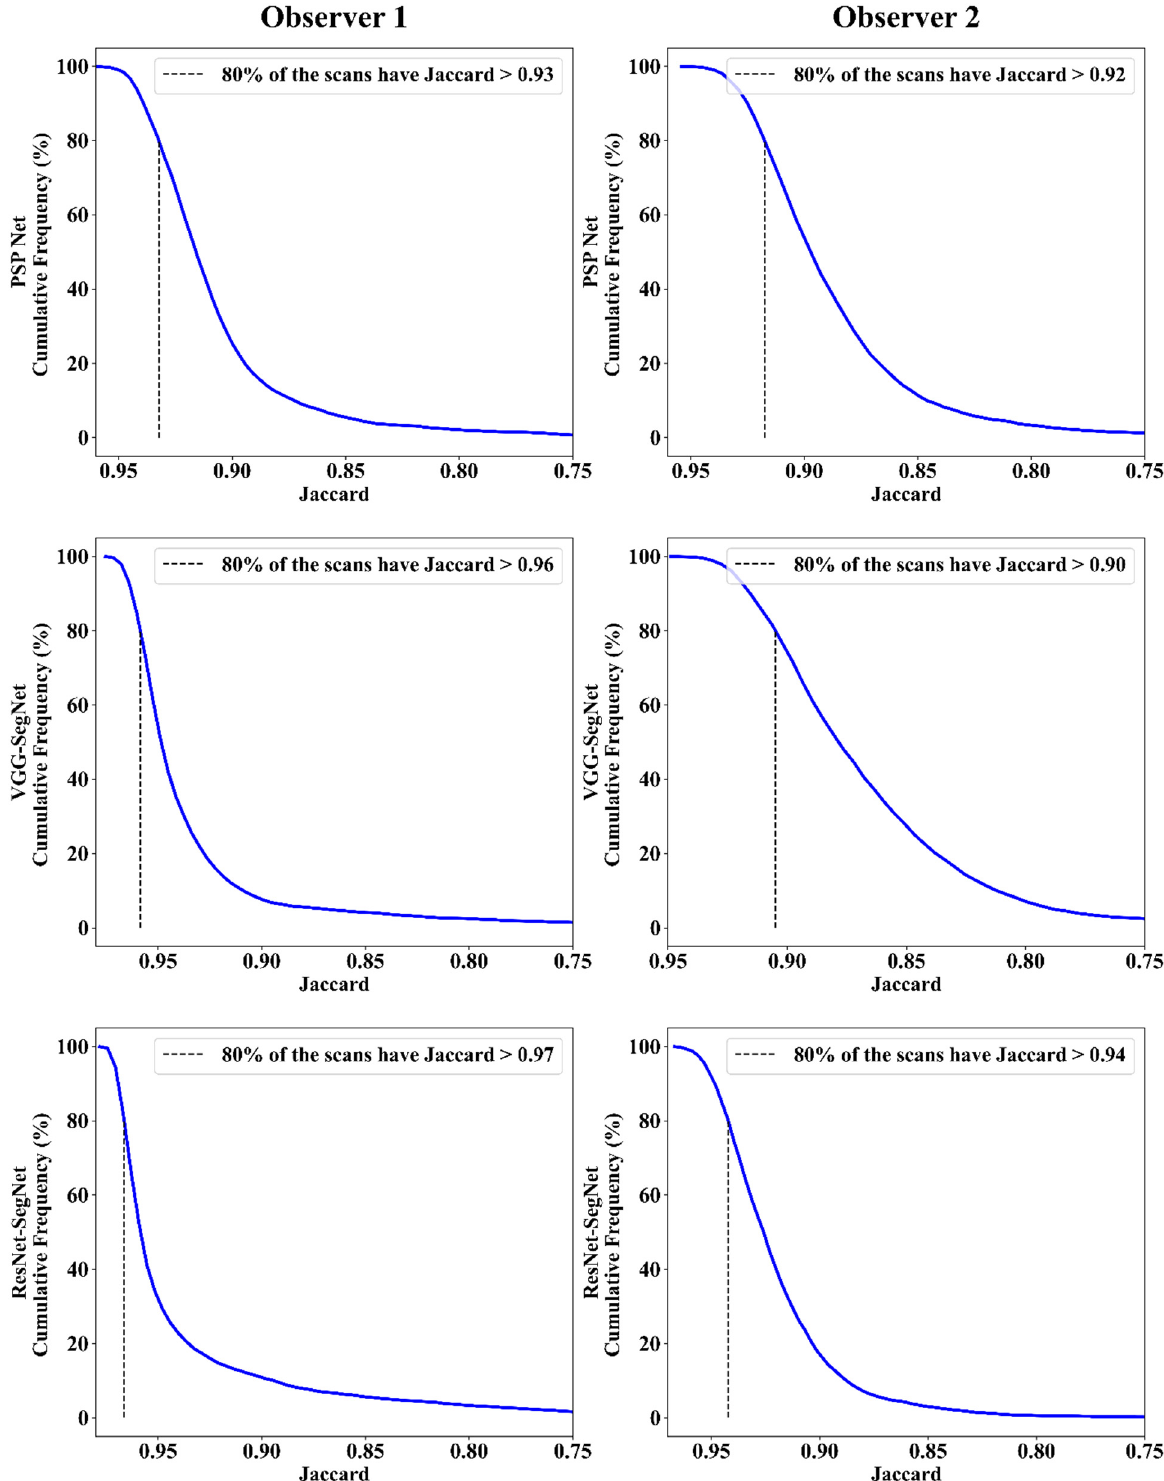
Figure 17. JI for combined lung using three AI models: Observer 1 vs. Observer 2.